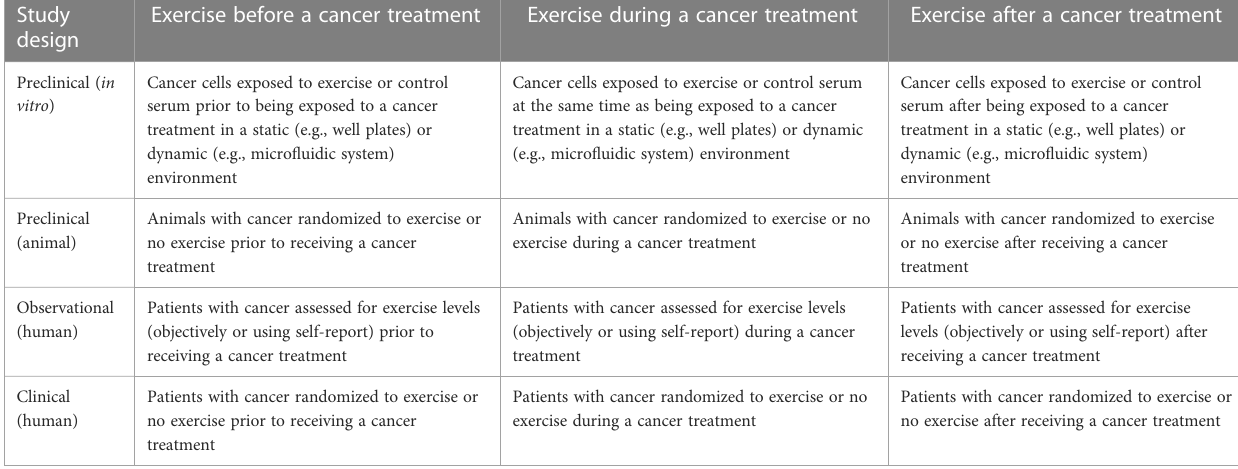
TABLE 1 Proposed methodology for addressing treatment sequencing effects of exercise across different study designs.